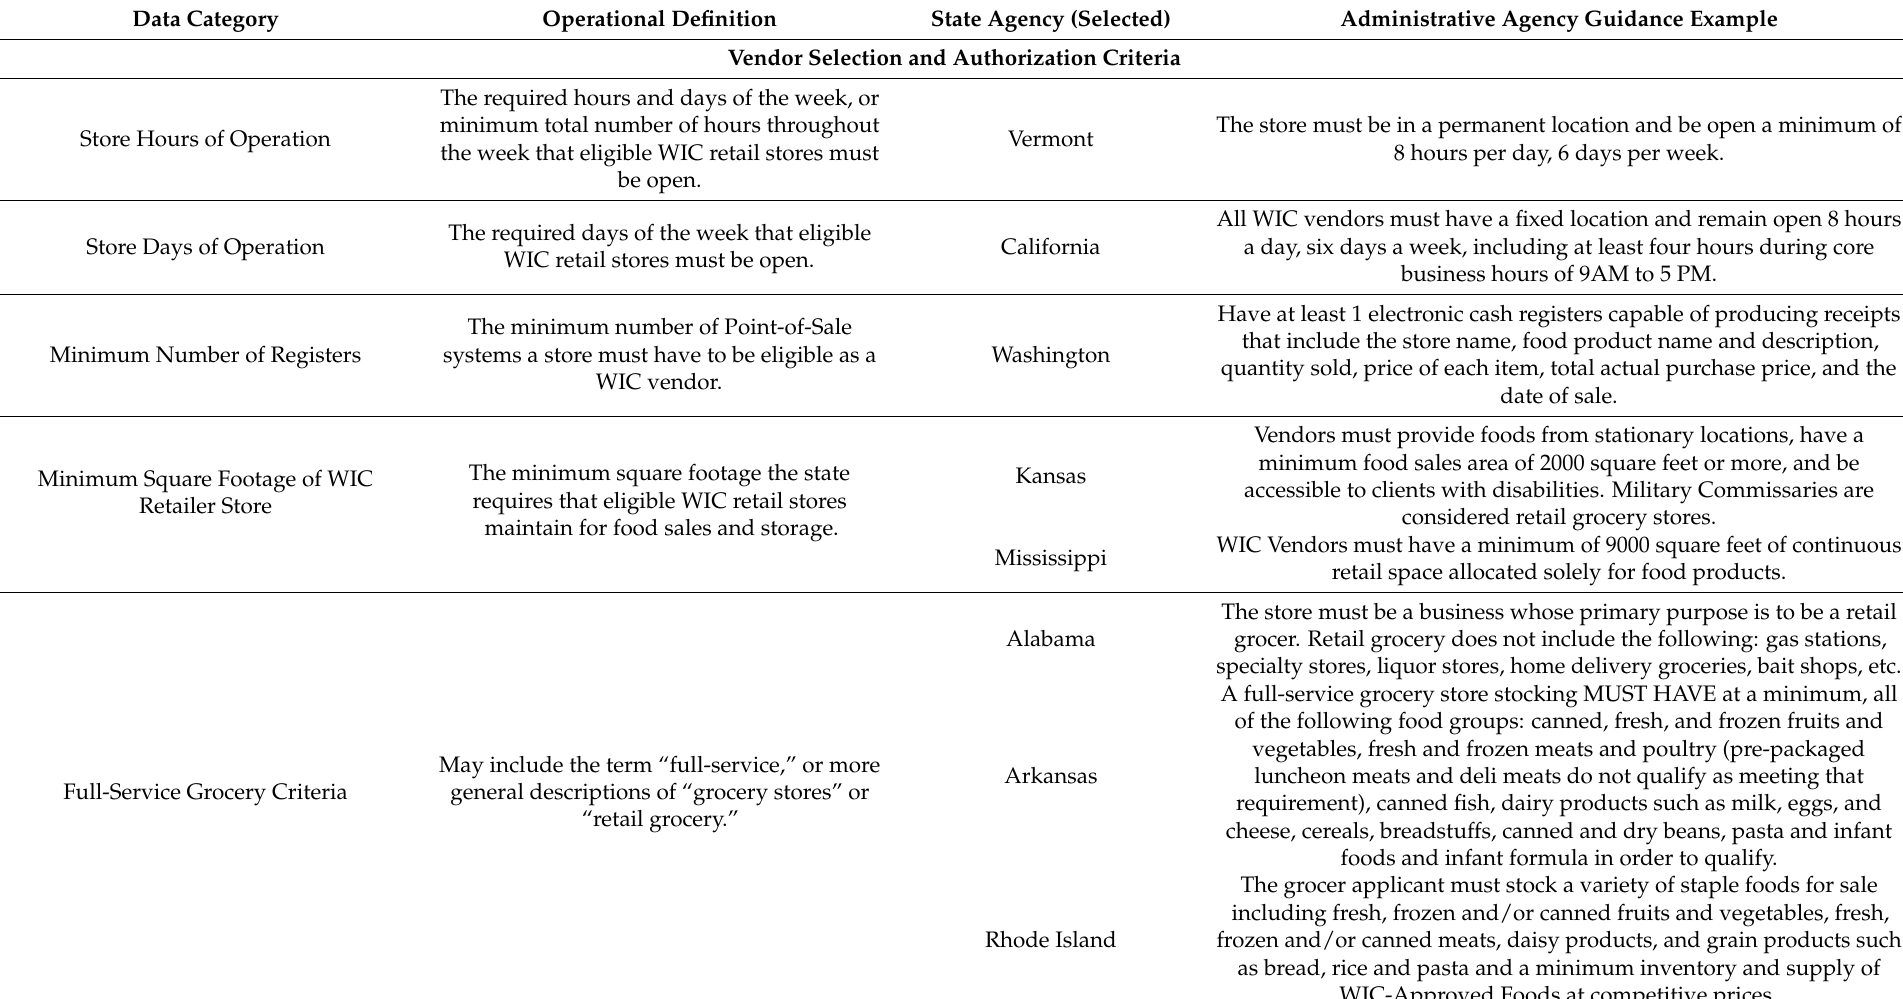
Table 1. Data Categories with Operational Definitions and Exemplars from Administrative Agency WIC Vendor Selection and Authorization Criteria and Vendor Management and Operations Policies,